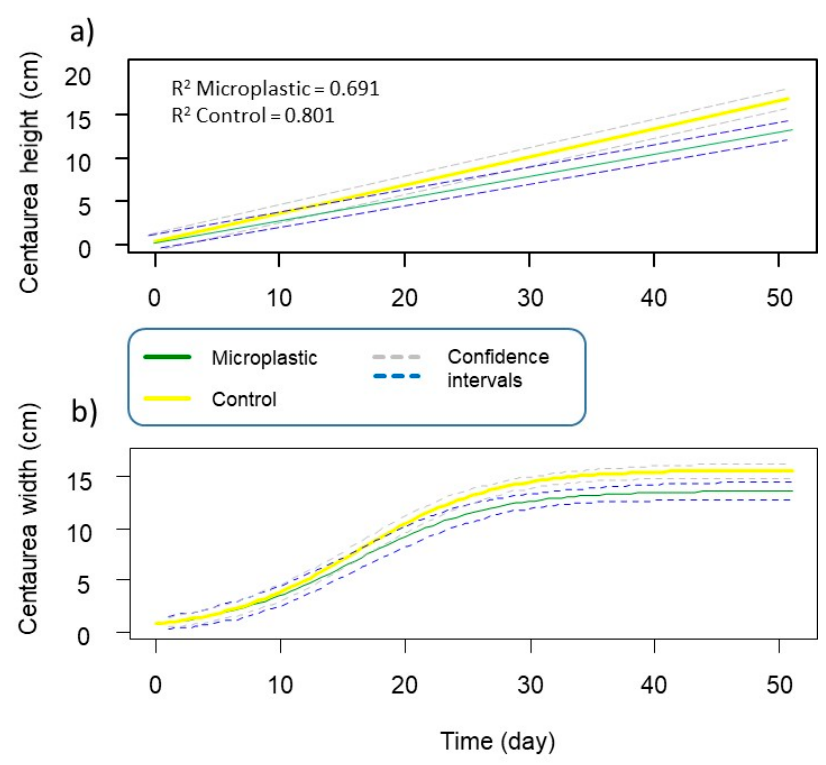
Figure 2. Linear and logistic growth trajectories for plant height ( a ) and width ( b ) of C. cyanus during a period of about two months.